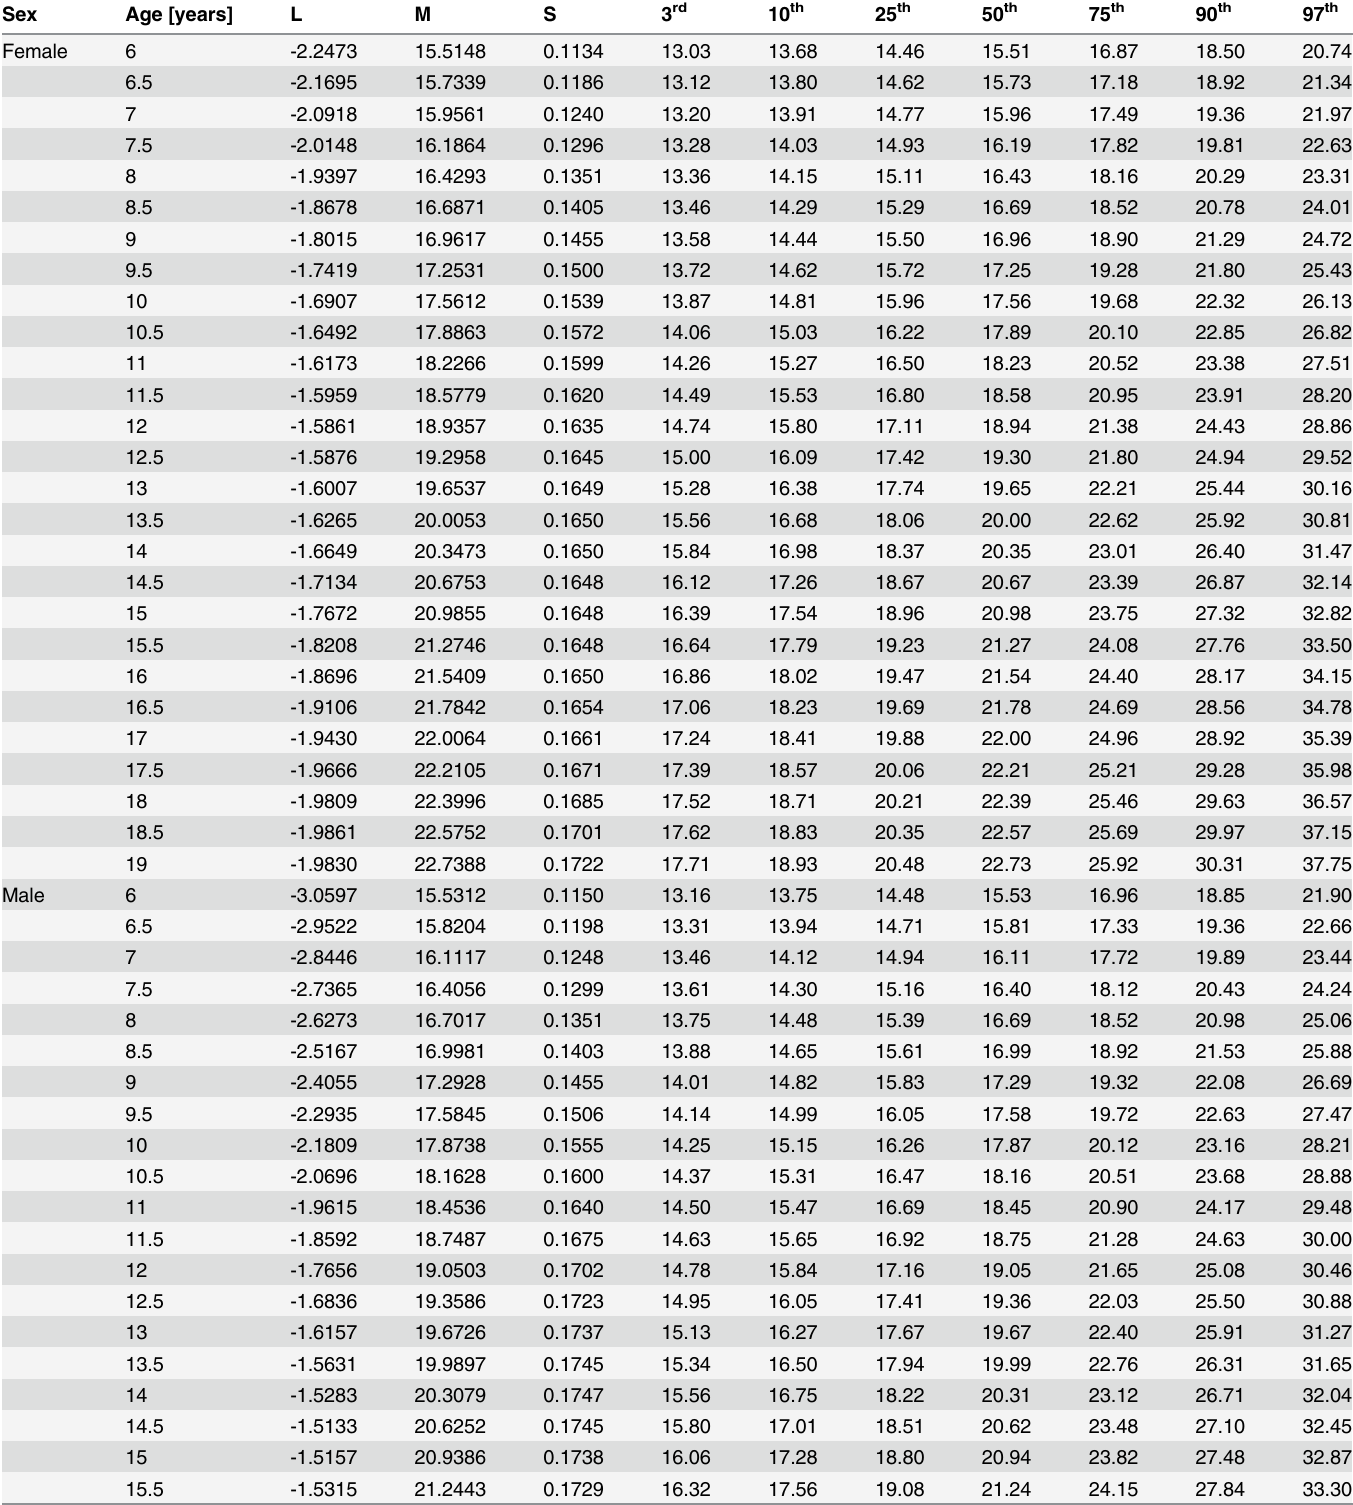
Table 2. L, M, and S values, and percentiles of body mass index [kg/m 2 ] by age and sex for Canadian children and youth aged 6 to 19